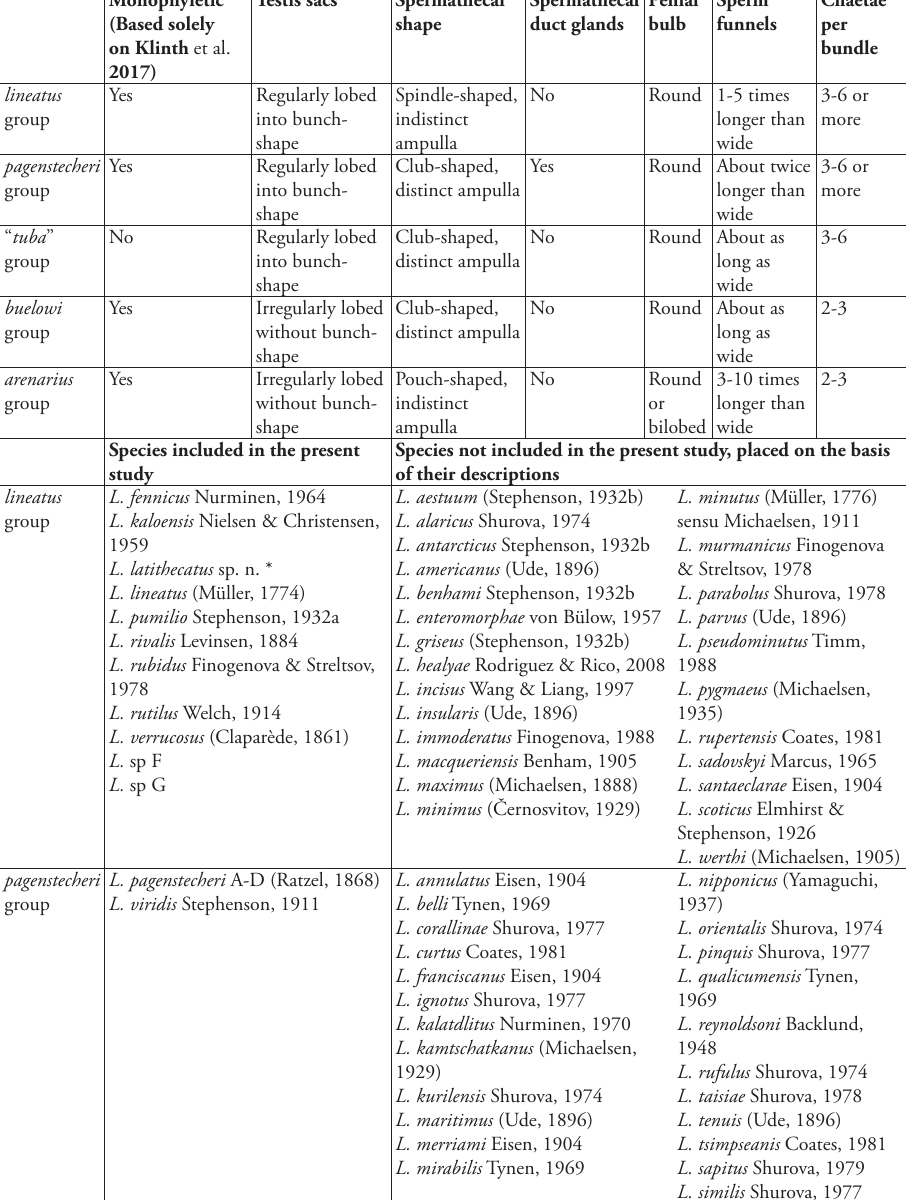
Table 1. The informal division of Lumbricillus into five morphological groups based on the phylogenies by Klinth et al. (2017), together with comparisons of some morphological characters. Furthermore, the Lumbricillus species not included in the present study are listed with tentative placements to one of these groups. Note that it is likely that some of the species not studied could upon closer examination prove to be synonyms to the included species in this study. * L. latithecatus sp. n. was referred to as L. sp. E in Klinth et al. (2017). ** L. scandicus was referred to as L. cf. helgolandicus in Klinth et al.